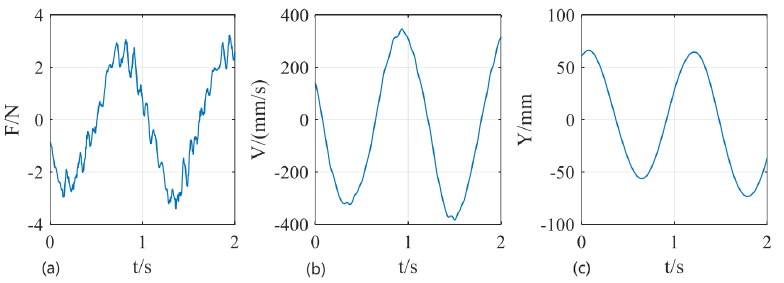
Figure 16. High sensitivity motion test of dragging operation: ( a ) contact force; ( b ) robot velocity; ( c ) robot